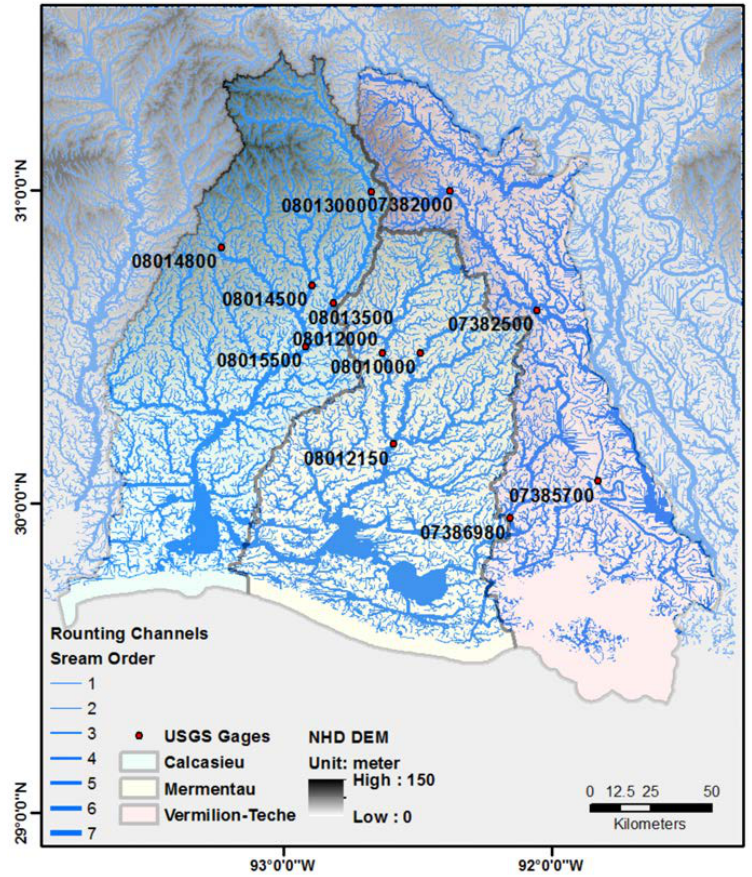
Figure 3. Routing channel grids developed using the WRF-Hydro ArcGIS toolbox. Also shown are digital elevation model (data source: National Hydrography Dataset, V2) and the location of USGS gauges used for streamflow